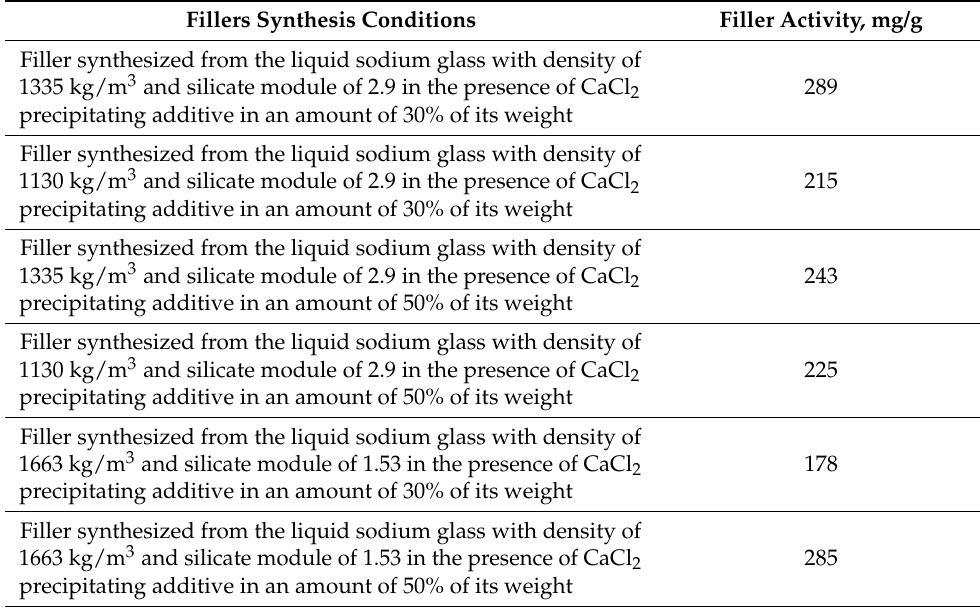
Table 7. Dependence of the filler activity on the synthesis